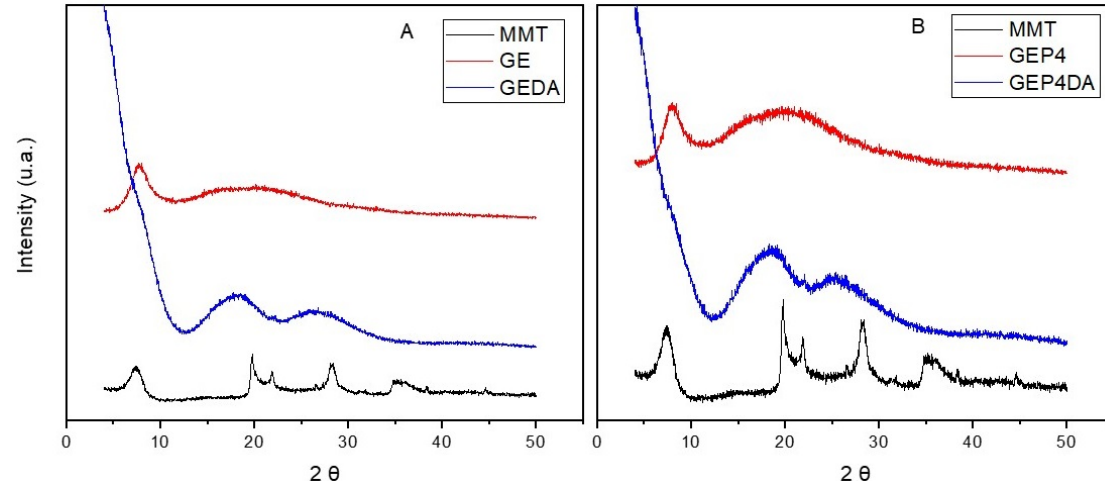
Figure 5. ( A ) X-ray diffractogram of MMT, GE and GEDA. ( B ) X-ray diffractogram of MMT, GEP4 and GEP4DA.